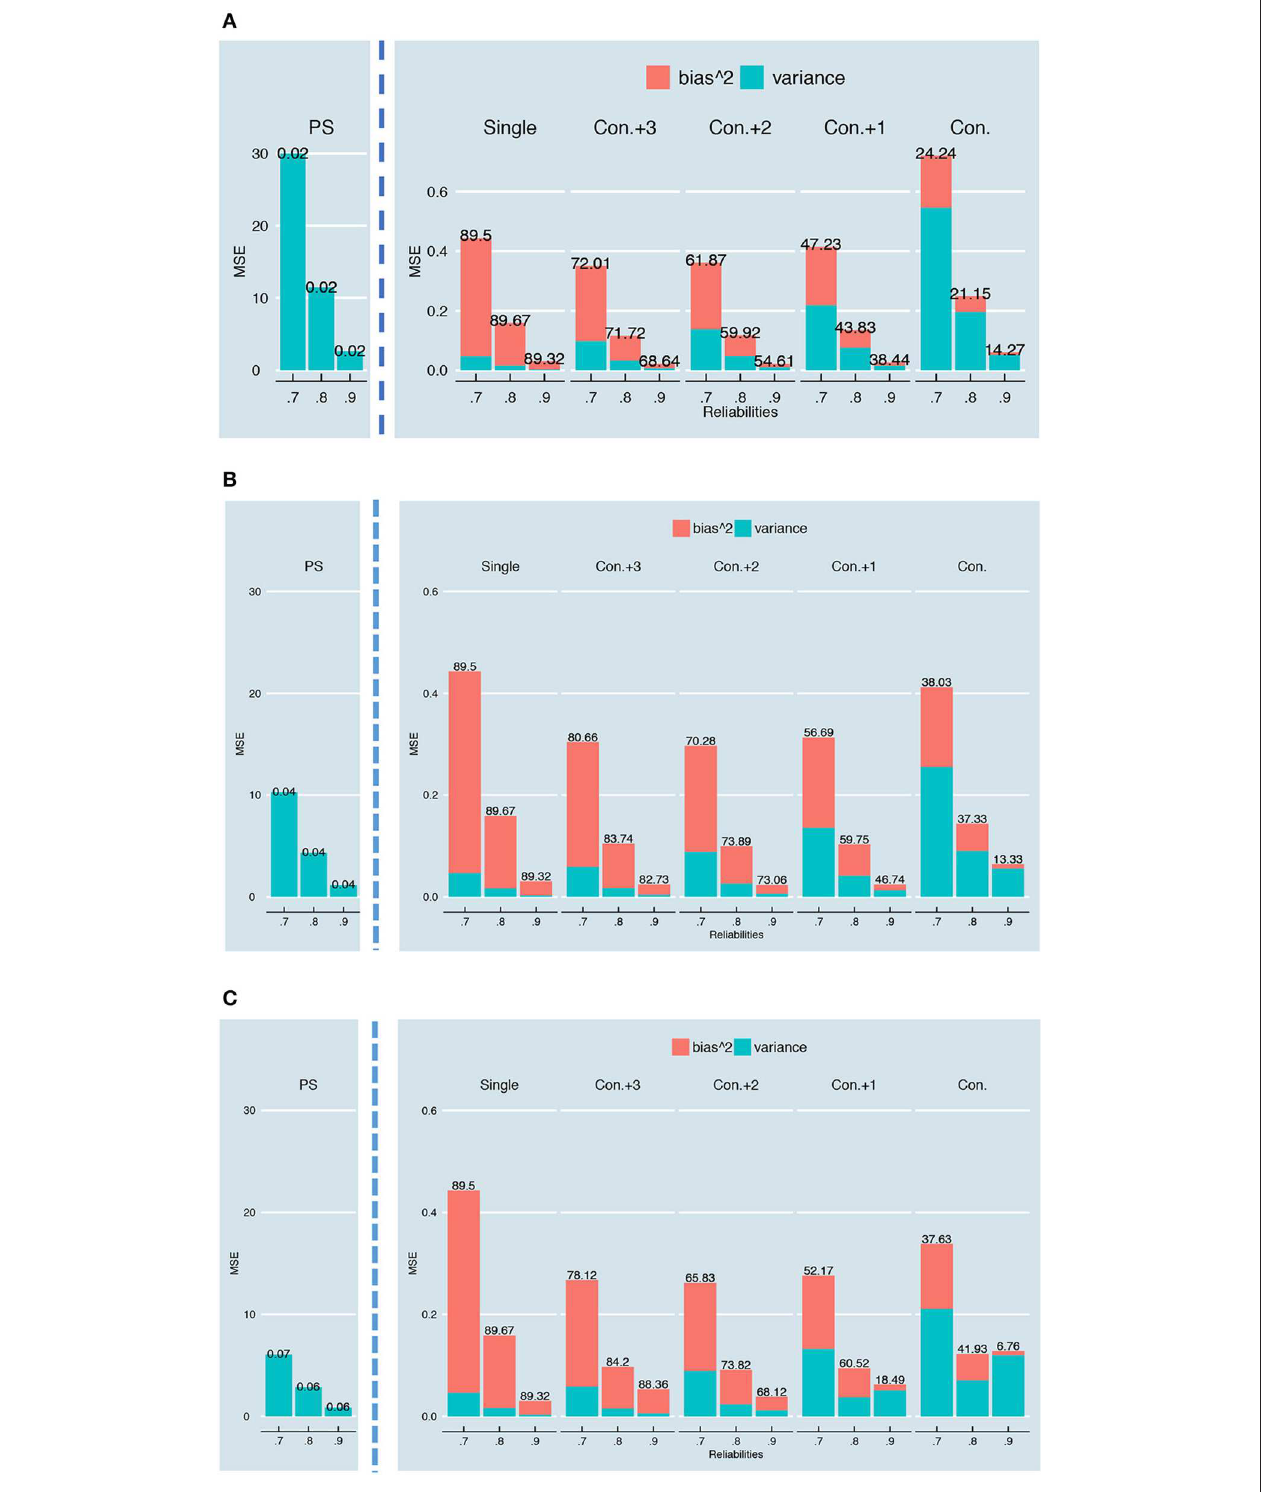
FIGURE 18 | Bias 2 , variance and MSE for a test with 24-items and K = 2 (A) , K = 4 (B) , and K = 6 (C) parallel test parts. The overall reliability of the test is varied on the x-axis. The numbers on top of the bars show the percentage of the MSE “caused” by the bias 2 , which is also reflected in the size of the stacked pink bar. Note that these plots are based on the relationship in Figure 5A ; similar plots for the other relationships can be requested from the first author.